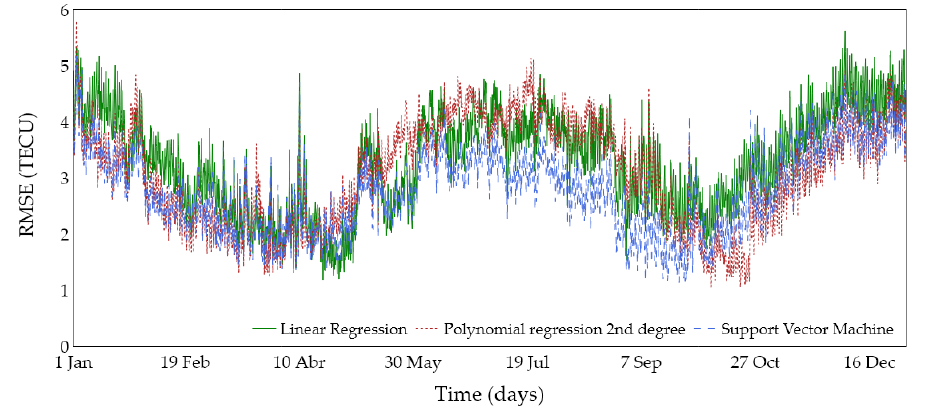
Figure 16. The temporal variation in global RMSE for 2019 (test set).